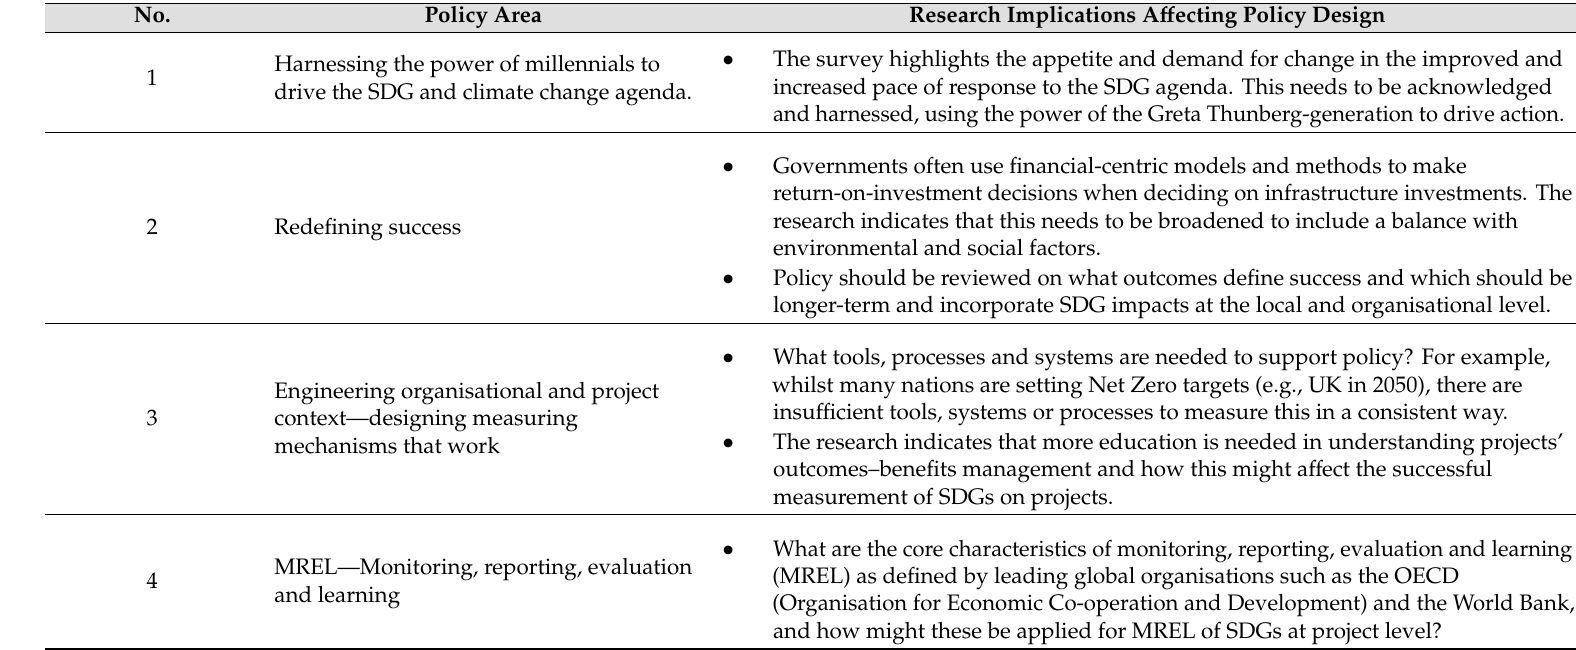
Table 4. Policy implications of